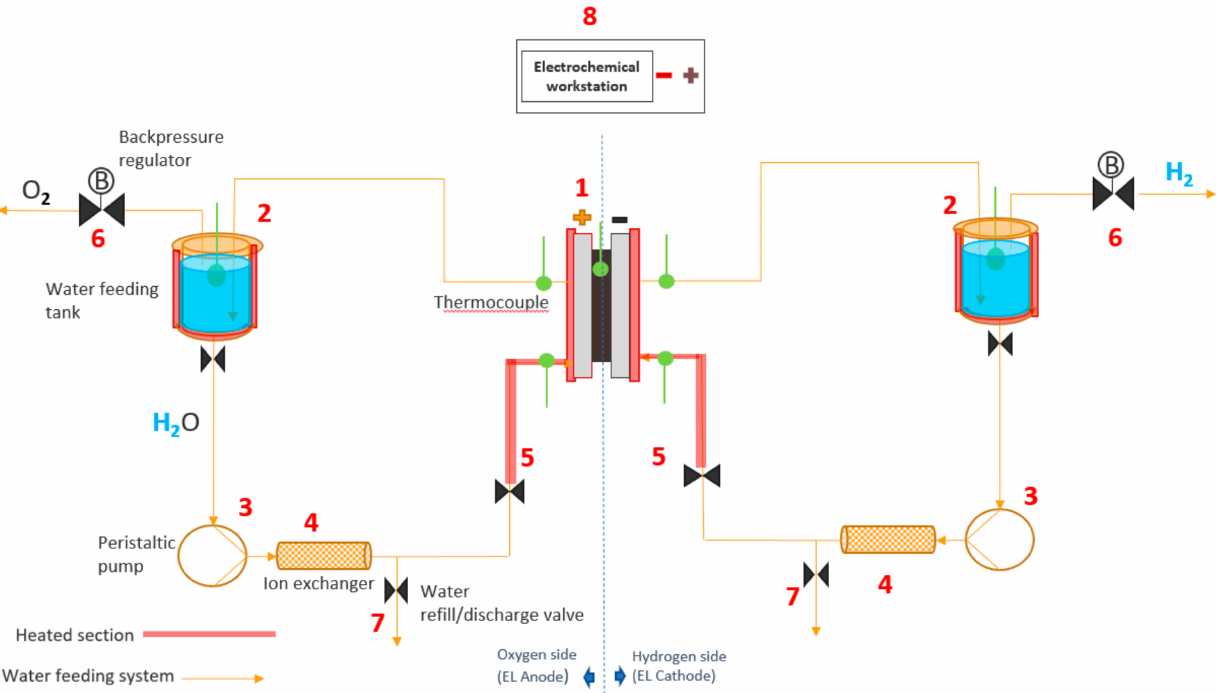
Figure 1. Experimental setup used for the in situ polarization curves and electrochemical impedance